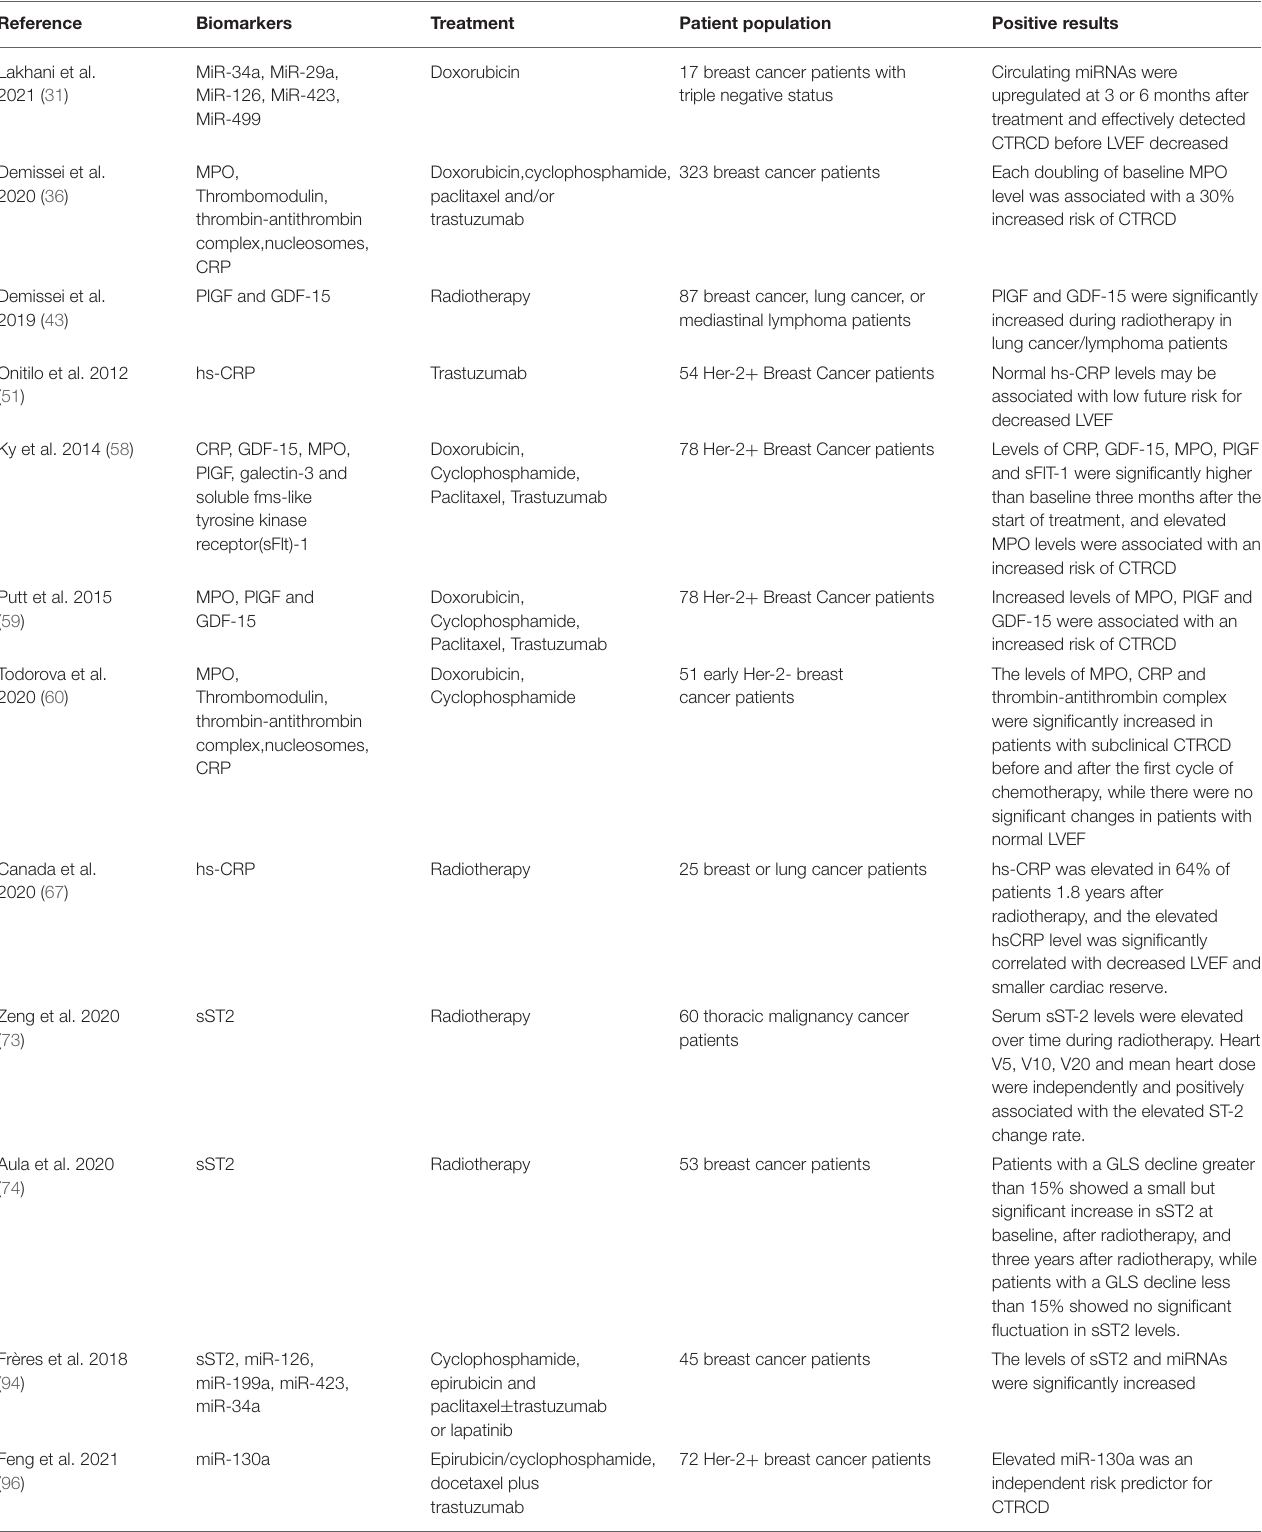
TABLE 1 | Researches on emerging biomarkers for